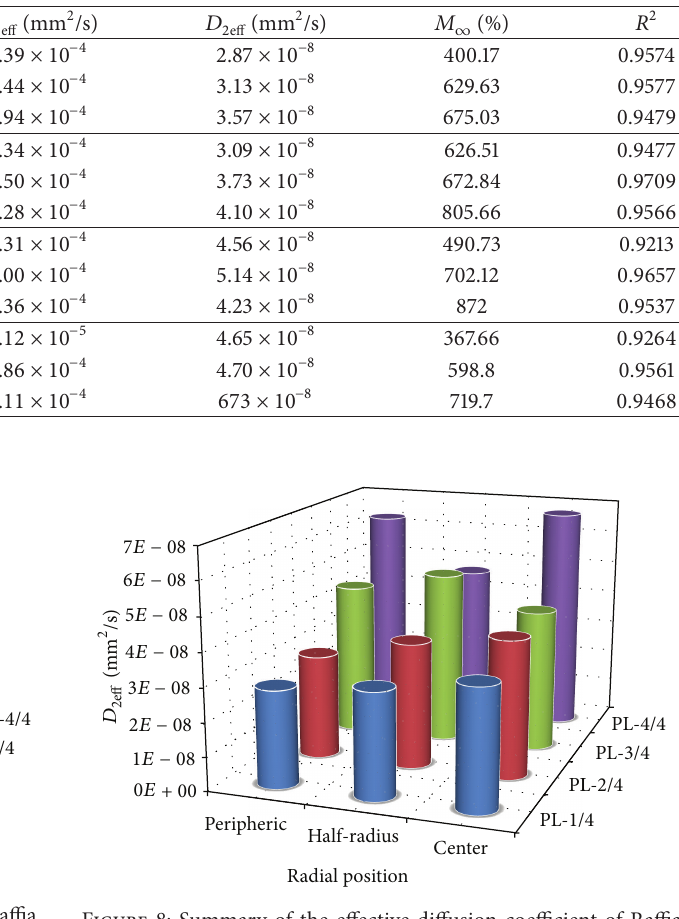
Figure 8: Summary of the effective diffusion coefficient of Raffia vinifera fibres during the intermediate or final phase of water absorption along the